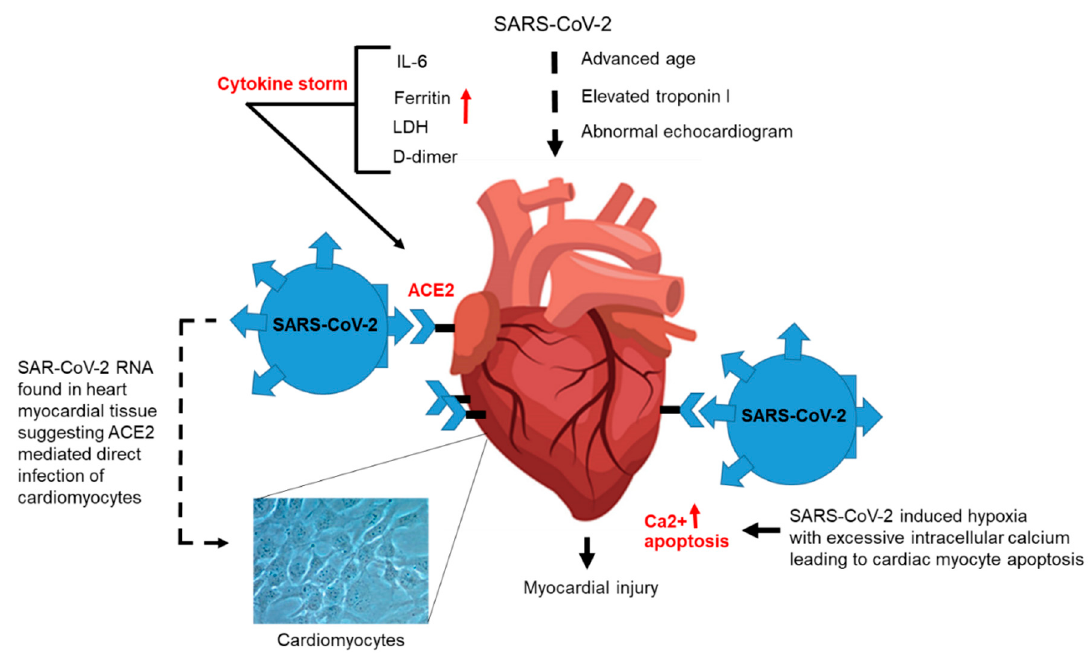
Figure 3. Cardiovascular disease (CVD) and increased risk for severe COVID-19 disease. Hypothetical model of patients with CVD and increased risk for complications due to COVID-19. CVD patients with advanced age and elevated troponin I levels, and who have abnormal echocardiograms, are at high risk for developing more severe COVID-19 disease. These patients have been shown to have increased blood levels of IL-6, ferritin, LDH, and D-dimer, which are associated with the cytokine storm that likely would contribute to cardiac injury. High levels of ACE2 are known to be expressed on cardiomyocytes that could result in direct infection of heart tissue by SARS-CoV-2, which is thought to induce hypoxia leading to increase calcium levels resulting in apoptosis and death of cardiomyocytes; this likely would contribute to myocardial injury.